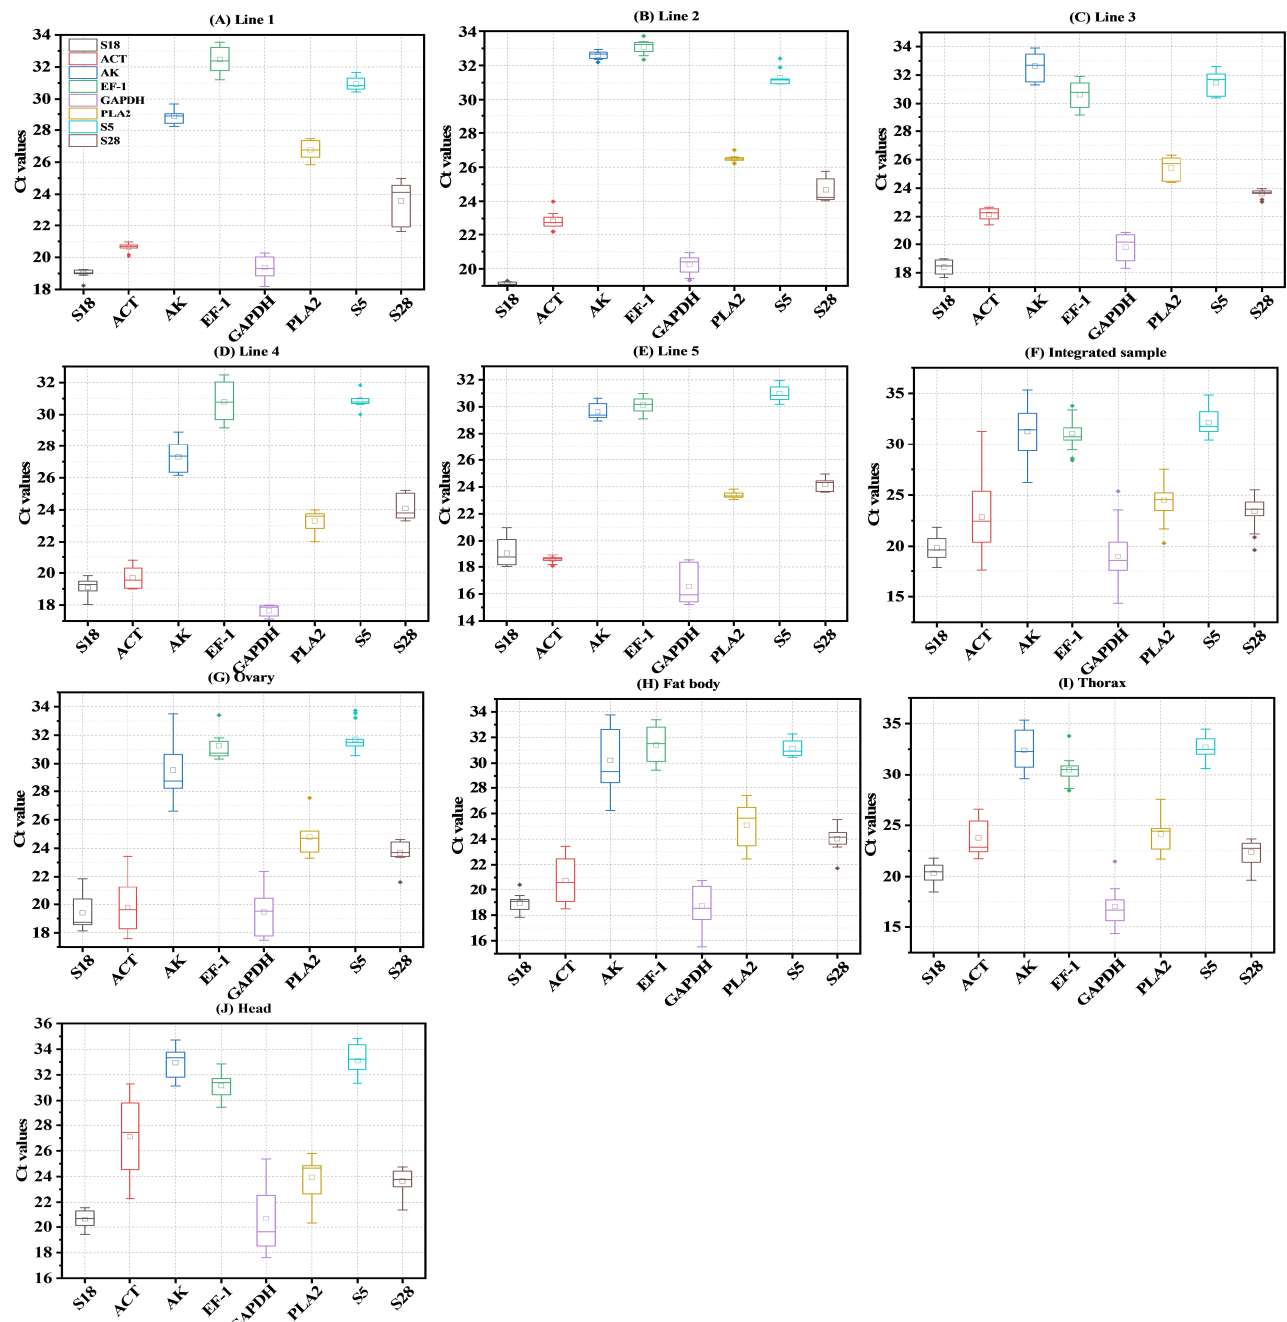
Figure 1. A box-and-whisker plot depicting the Ct value range of the eight candidate reference genes in the bumble bee samples. B. terrestris line samples (( A ) line 1, ( B ), line 2, ( C ), line 3, ( D ), line 4, ( E ), line 5)), ( F ), Integrated samples of B. terrestris . (( G ) head, ( H ) thorax, ( I ) fat body, ( J ) ovary)), Tissues and reproductive organs samples of B. terrestris. The values of three biological replicates are presented as the average of three technical replicates. The whiskers represent the n-sample standard deviation. The error bars represent the highest and lowest values. The dots represent outliers (replicated samples with Ct values greater than 50% of the interquartile